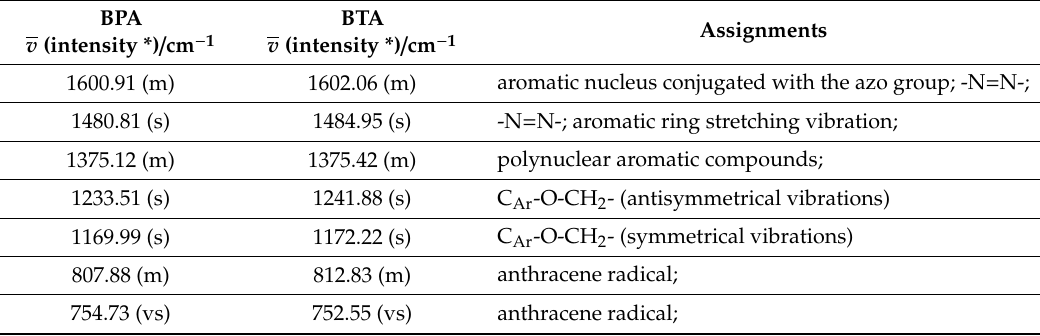
Table 1. Transmittance in the main infrared absorption maxima of BPA and BTA and their assignments